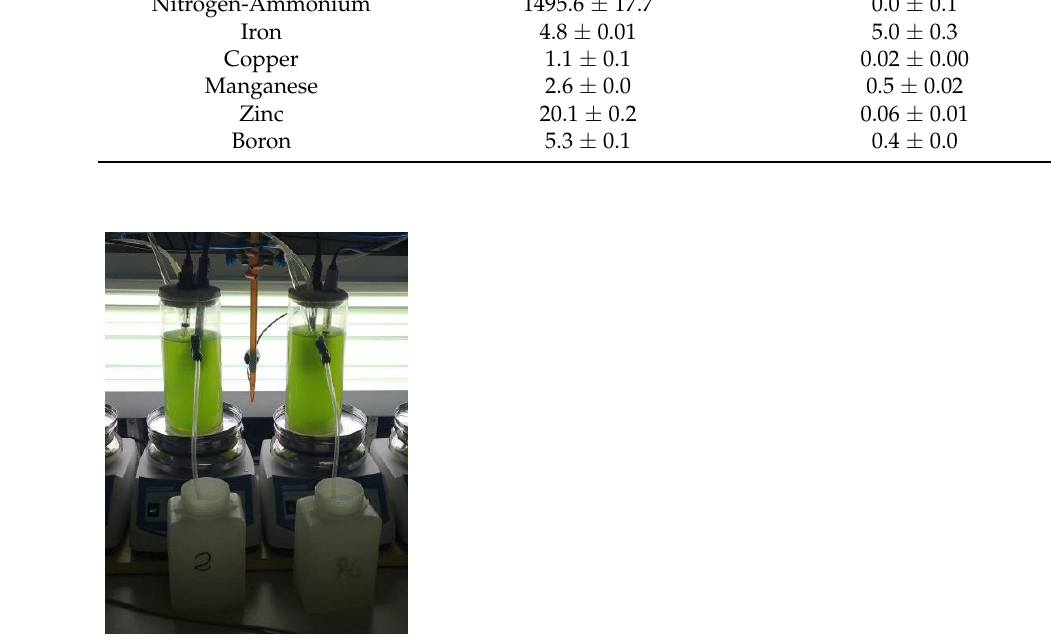
Figure 1. Laboratory photobioreactors used for performing the experiments. Table 1. Average compositions of the culture medium and piggery wastewater used as the influ- ent in the bioreactors. Concentrations expressed as mg × L −1 .